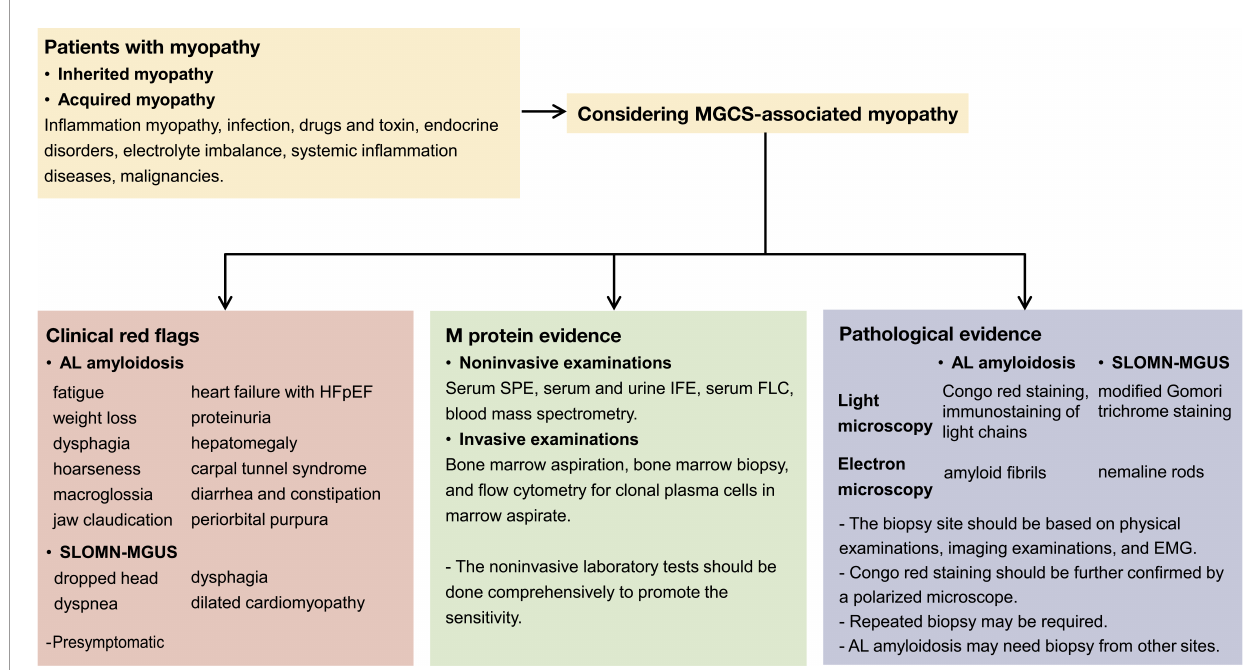
FIGURE 3 | Workup for patients suspected of MGCS-associated myopathy. Clinical red fl ags if presented may suggest AL amyloidosis or SLOMN-MGUS. Systemic damages are common in AL amyloidosis, and some presymptomatic signs should also be noted in AL amyloidosis. M protein screening (comprehensive noninvasive and invasive bone marrow examinations) is required for diagnosis. Pathological evidence is crucial for MGCS-associated myopathy diagnosis. Special staining methods such as Congo red staining for AL amyloidosis and modi fi ed Gomori trichrome staining for SLOMN-MGUS are useful. Light chain immunostaining is only useful for AL amyloidosis. Electron microscopy is indispensable for differential diagnosis.